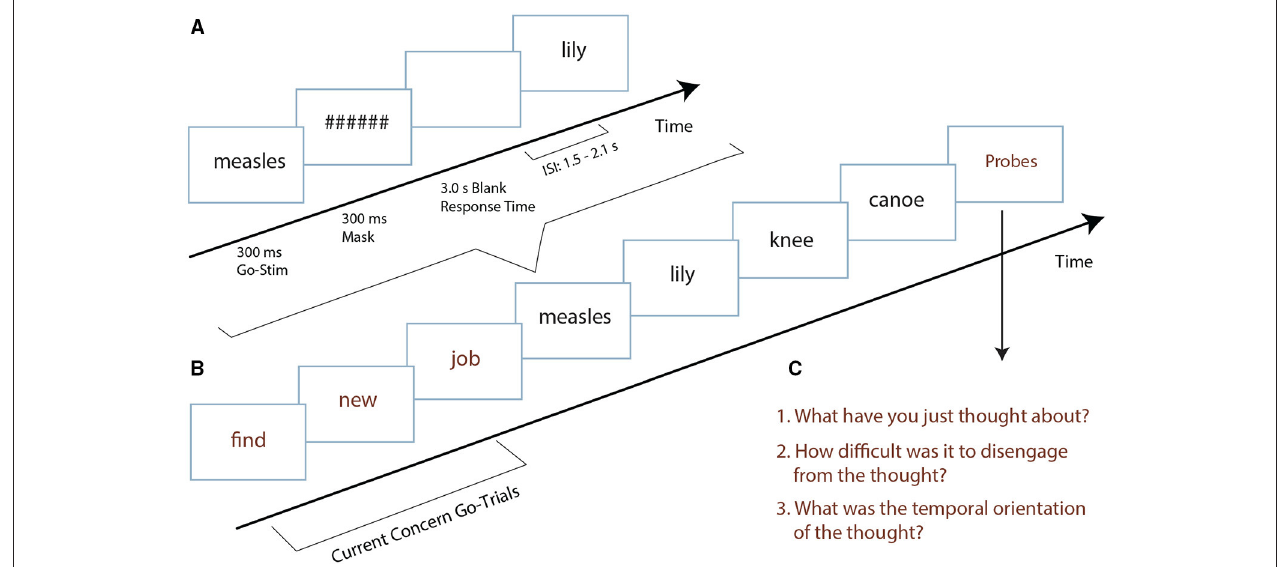
FIGURE 1 | (A) Temporal structure of an individual trial. (B) Trial structure. In this example there are four trials in-between the current concern trials and the thought probes. (C) Thought probe questions. The first question asks about the content, the second asks about the stickiness of the content, the third asks about the temporal orientation of that content (stimuli were translated from Dutch to English for display